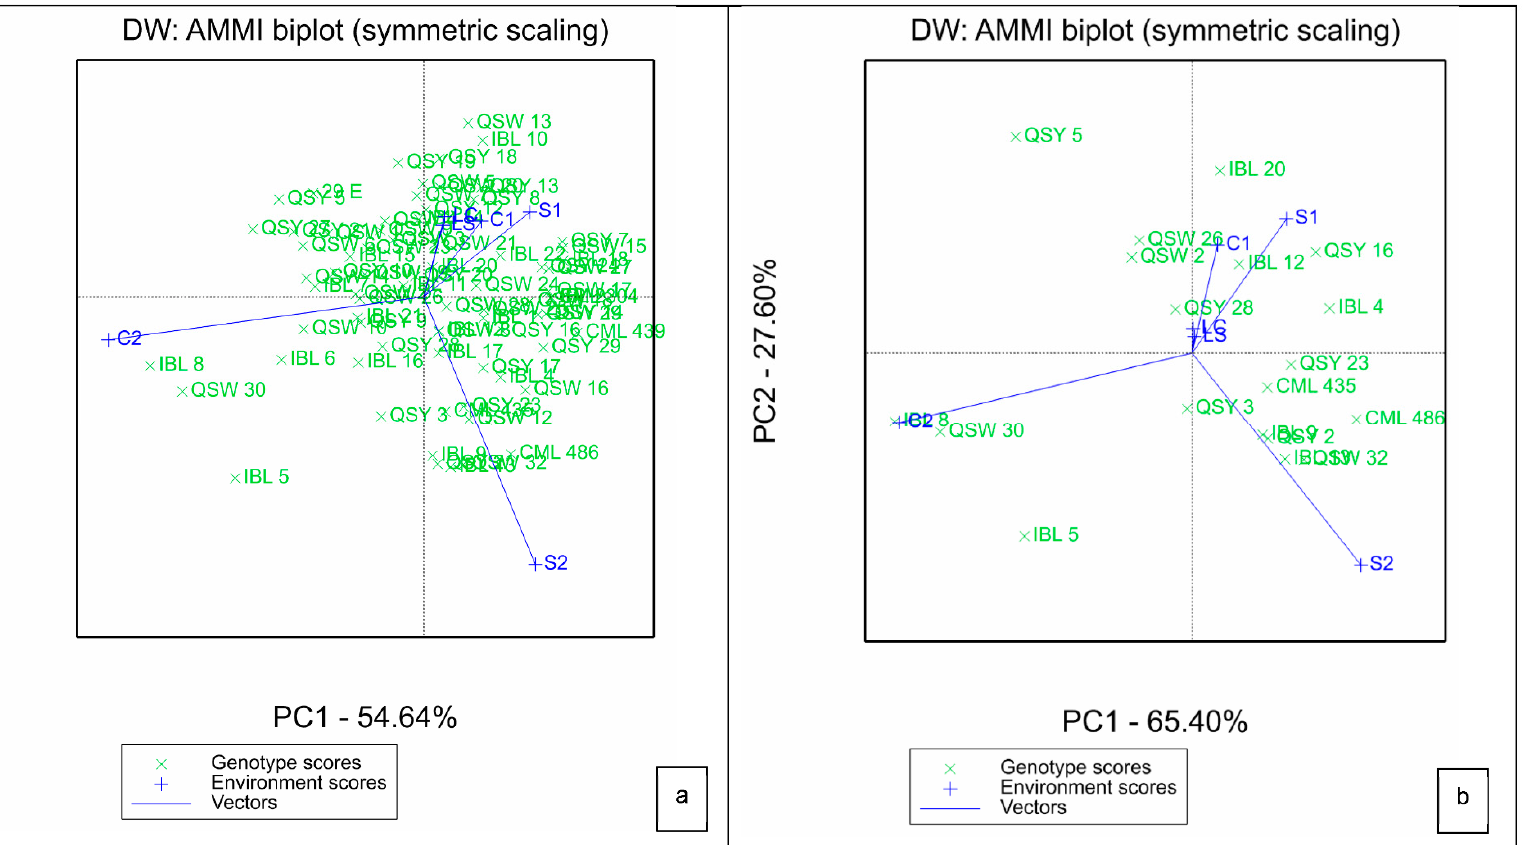
Figure 1. Additive main effects and multiplicative interaction biplot for IPCA 1 and IPCA 2 scores of ( a ) all the 75 QPM genotypes and ( b ) 20 highest yielding genotypes ( b ) and six environments. S1: Al toxic environment under soil bioassay conditions in the greenhouse 1; S2: Al toxic environment under soil bioassay conditions in the greenhouse 2; C1: control environment under soil bioassay conditions in the greenhouse 1; C2: control environment under soil bioassay conditions in the greenhouse 2; LC: control environment under nutrient solution conditions, LS: Al toxic environment under nutrient solution conditions.